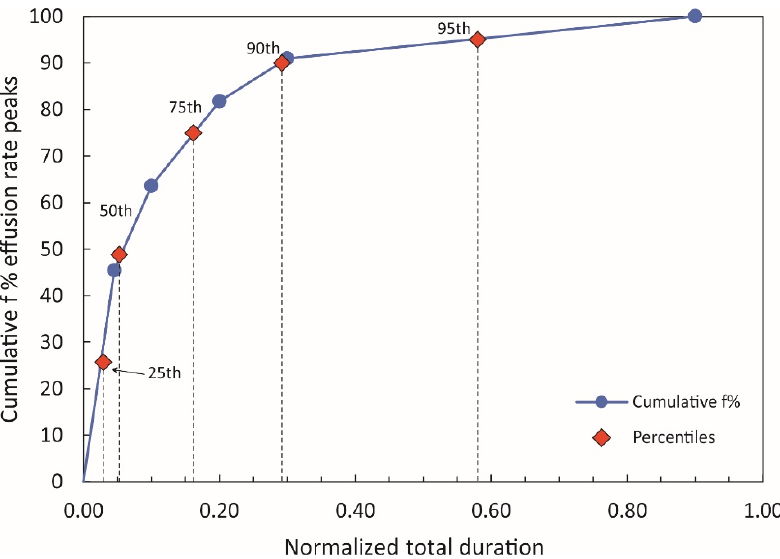
Figure 3. Plot of the percentage cumulative frequency of the effusion rate peaks’ occurrence, and the corresponding 25th, 50th, 75th, 90th and 95th percentiles.